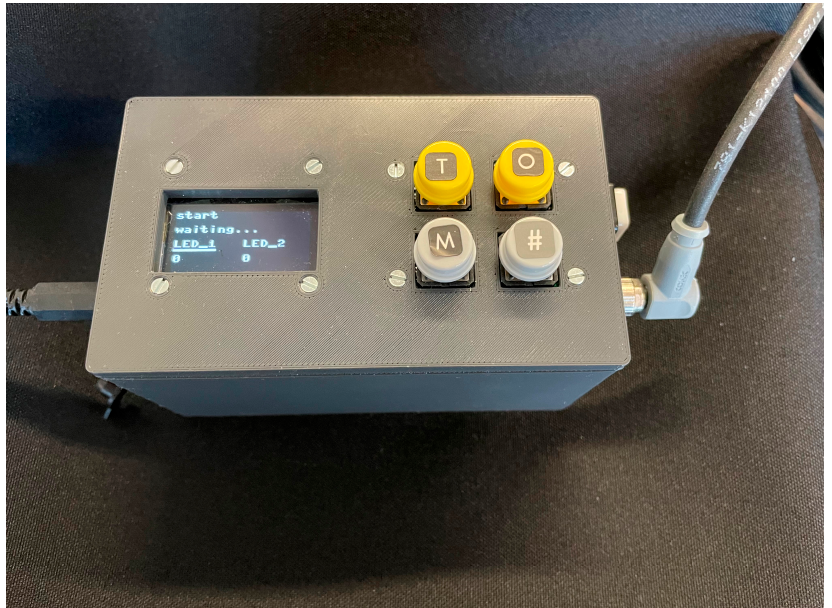
Figure A6. Electronic schematic of the controller unit. The illumination module is illustrated by the LED symbol and is controlled by the MW_LDD-H constant current source with a 300 mA forward current. The PWM input signals are grounded by the 10 k Ω resistors R1 and R2. Power for the PI_PICO (Raspberry Pi Pico) is supplied by a TSR-1 step-down converter (3.3 V). The ON/OFF switch is in the form of an interconnected pressure switch. BUTTON_XYs are tactile buttons used as input signals for the script. An OLED display is directly connected to and powered by the micro- controller.